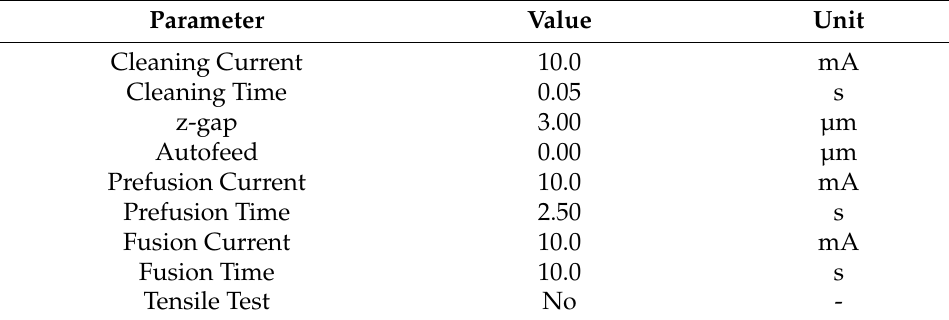
Table 2. Fusion Splicer Settings for Capillary